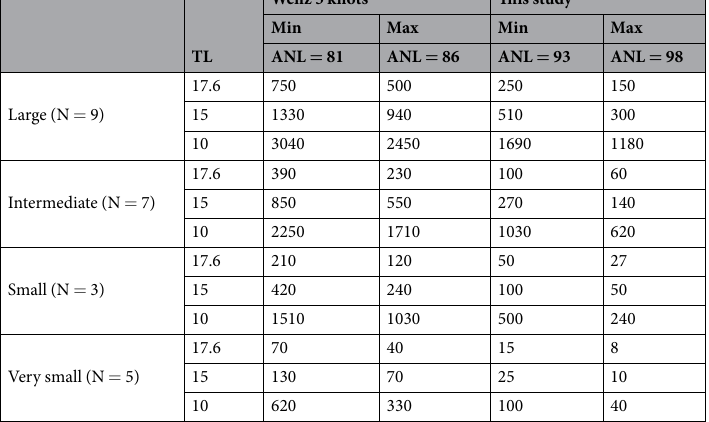
Table 1. Estimations of detection ranges (in m) of antennal rasps produced by spiny lobsters underwater. The averaged values are reported per group of size-matched spiny lobsters (see Material and Methods for details). The different transmission losses (TL) used correspond to the global TL ( a = 17.6) calculated between all spiny lobsters (except the very small ones), and the theoretical models of cylindrical TL ( a = 10) and practical ( a = 15) TLs. Min is signal-to-noise ratio (SNR) = 5 dB and max is SNR = 10 dB.